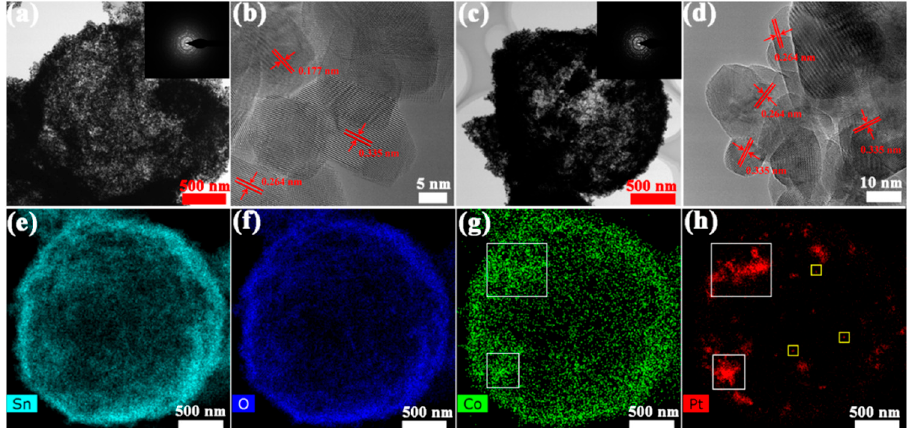
Figure 5. ( a , b ) TEM and HRTEM images of S1 (pure SnO 2 ). ( c , d ) TEM and HRTEM images of S4. ( e – h ) EDS elemental mapping images of Sn ( e ), O ( f ), Co ( g ) and Pt ( h ).